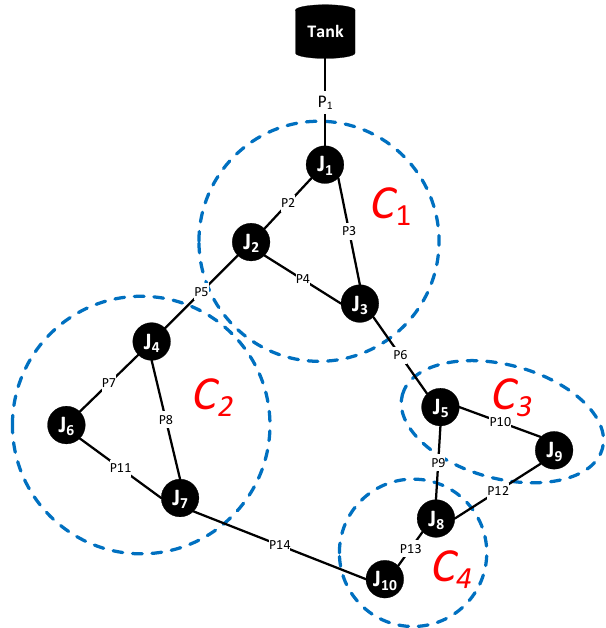
Figure 3. A simple network partitioned into four